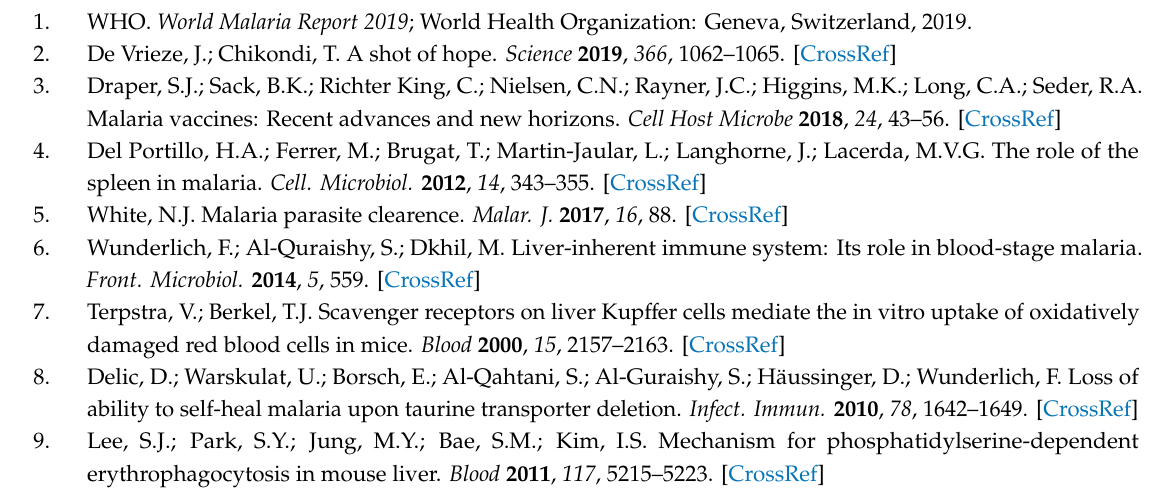
Table S1: Heatmap of hepatic expression profiles of NK cell-associated genes used for analyses in the present